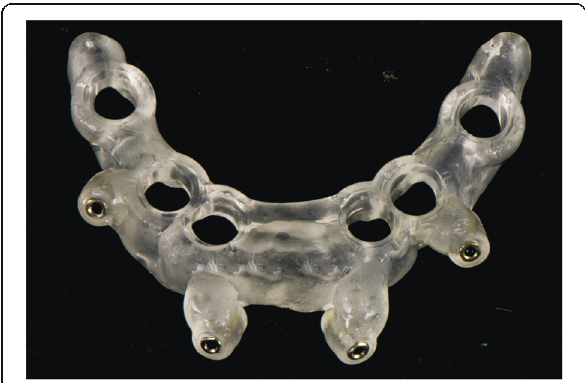
Fig. 7 Computer-aided design of interim prosthesis